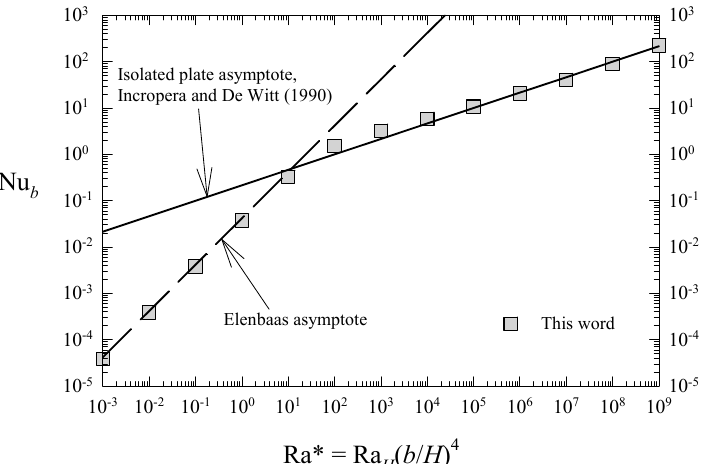
Figure 2. Validation of the numerical computations through comparisons with benchmark, asymptotical solutions for thermally fully-developed flow (Elenbaas [1] asymptote, Nu b = Ra* / 24) and isolated-plate limit (Incropera and De Witt [2], Nu b = 0.1(Ra*) 1 / 3 ). Configuration of a simple vertical channel of Figure 1a, with b / H = 0.1. Note that the average Nusselt number is based on b .